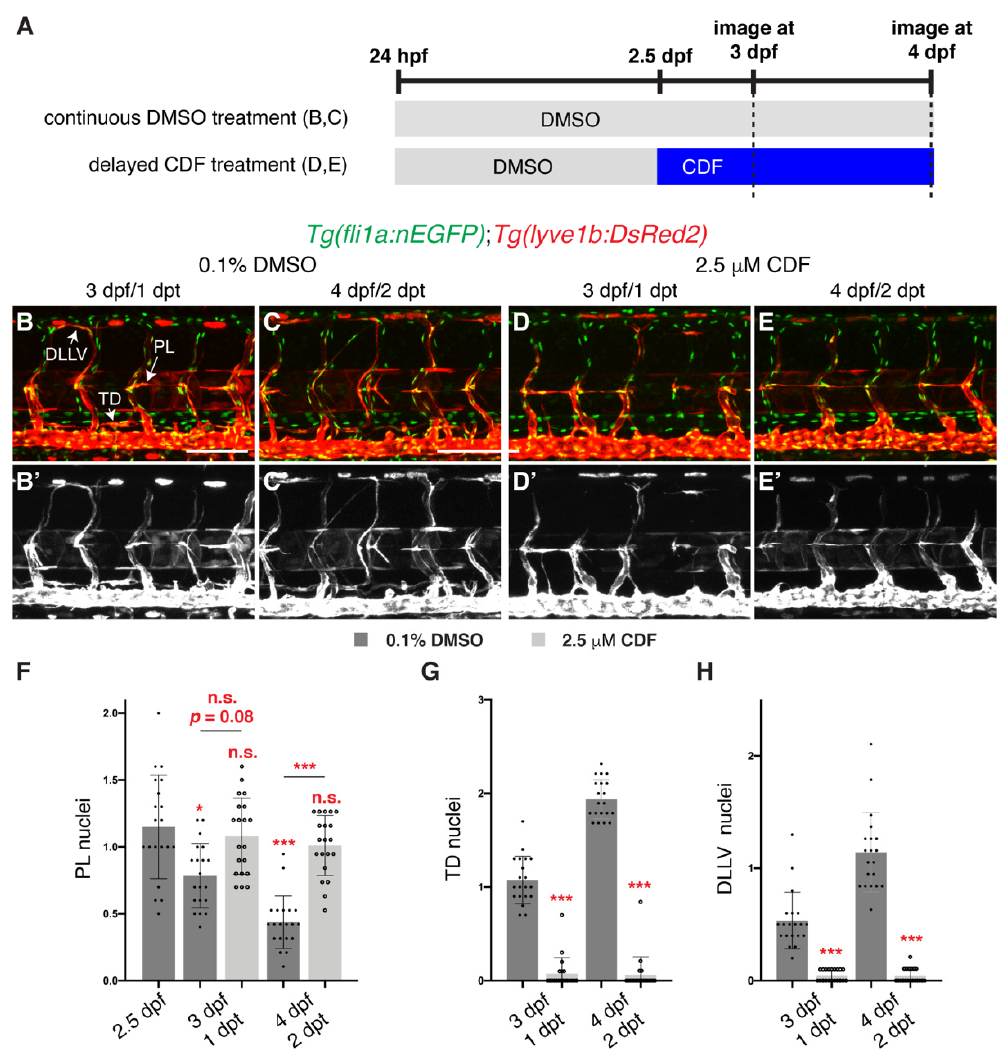
Figure 2. 3,4-Difluorobenzocurcumin treatment inhibits lymphatic migration. ( A ) Schematic representation of the treatment schedule for larvae in images ( B – E’ ). ( B – E’ ) Lateral confocal images of 3 (1 days post-treatment (dpt), B , B’ , D , D’ ) and 4 (2 dpt, C , C’ , E , E’ ) dpf Tg(fli1a:nEGFP);Tg(-5.2lyve1b:DsRed2) larvae treated from 2.5 dpf with either 0.1% DMSO ( B – C’ ) or 2.5 µ M 3,4-Difluorobenzocurcumin (CDF, D - E’ ). LEC migration is stalled in larvae treated with CDF. Images ( B’ – E’ ) represent the Tg(-5.2lyve1b:DsRed2) expression of images ( B – E ). ( F – H ) Quantification of parachordal LECs (PL, F ), thoracic duct (TD, G ) or dorsal longitudinal lymphatic vessel (DLLV, H ) nuclei per somite in Tg(fli1a:nEGFP);Tg(-5.2lyve1b:DsRed2) larvae treated with either 0.1% DMSO or 2.5 μ M CDF at indicated timepoints (n = 20 embryos/larvae). Statistical test: Kruskal-Wallis test was conducted for graph F and Mann-Whitney test were conducted for graphs G and H. p ≤ 0.001 (***), p ≤ 0.05 (*), n.s. indicates not significant. Scale bars: 100 μ m. 2.3. CDF Inhibits VEGFC-Induced ERK Signalling in Human Endothelial Cells In Vitro and Zebrafish Endothelial Cells In Vivo VEGFC is essential for lymphatic development as deletion of VEGFC results in lack of lymphatic sprouting and migration in both fish and mammals [34,36–40]. VEGFC is able to bind to both VEGFR2 and VEGFR3 to activate downstream serine/threonine ki- nases such as ERK and AKT in LECs [41]. Hence, CDF may exert its anti-lymphangiogenic effect by targeting VEGFC-induced VEGFR-dependent phosphorylation of endothelial ERK and/or AKT. To investigate this, we used a human endothelial cell culture system with human dermal lymphatic microvascular endothelial cells (HMVECs). As expected, treatment with SM diminished VEGFC-induced ERK and AKT phosphorylation (Figures 3A, S3A,B and S4). Treatment of HMVECs with CDF resulted in a dose-dependent